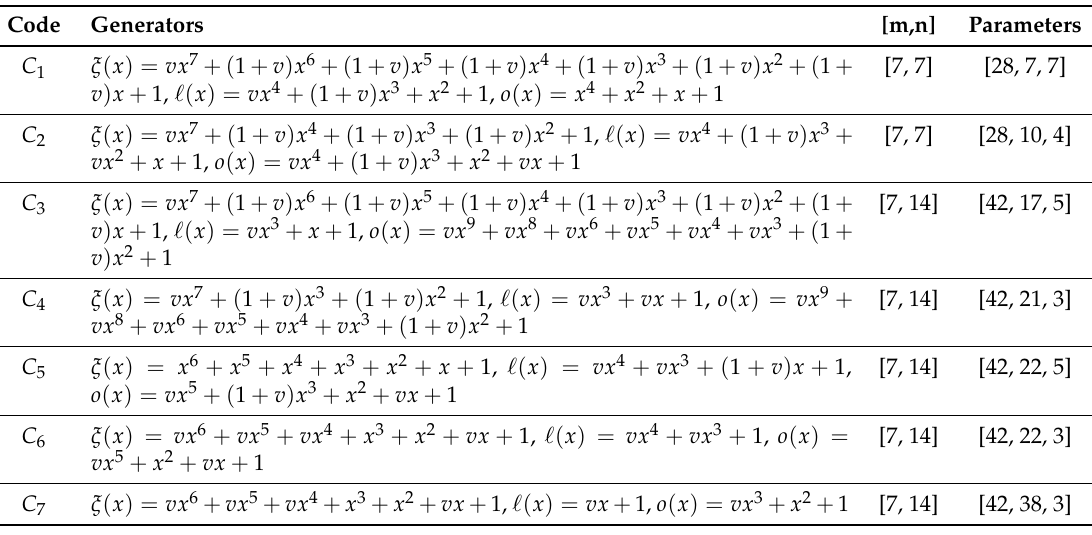
Table 2. Table of F 2 + v F 2 -double cyclic codes.